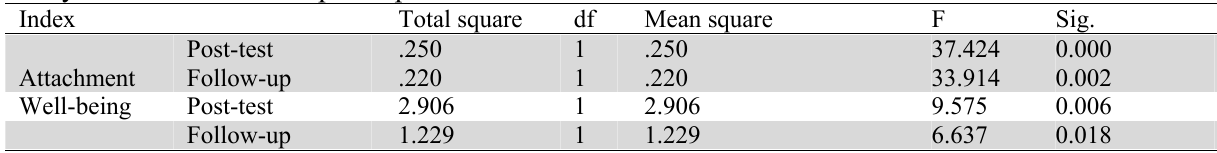
Analysis of covariance of participants’